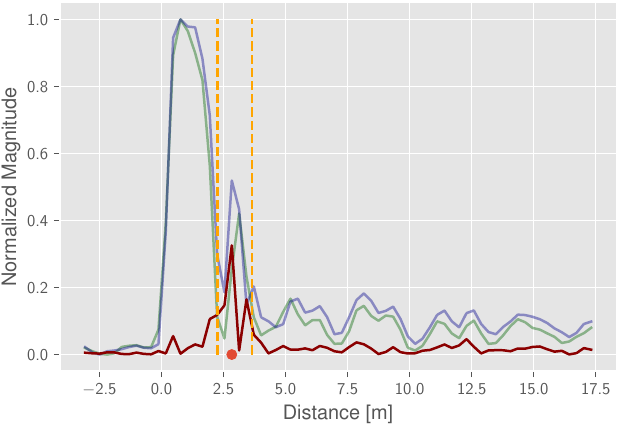
Figure 6. Subtraction and reflection path estimation: CIR with the object (blue), static background CIR (green), subtracted CIR (red), detection corridor (orange) and estimated reflection path (red